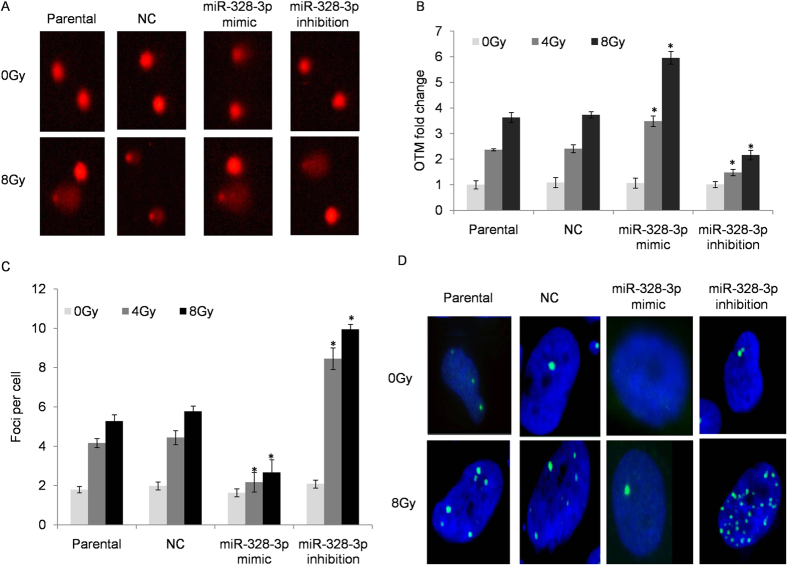
miR-328-3p over-expression increased radio sensitivity and promoted DNA damage of A549 cells.(A,B) Comet assay was performed to evaluate DNA damage response following miR-328-3p transfection. ANOVA test was used to determine the statistical significance of differences among the groups. Results presented as mean ± SEM of values obtained in three independent experiments. (C,D) Blue represents stained nuclei and green represents stained γ-H2AX foci. Mean number of foci per cell for various doses shown after 0 to 8 Gy of irradiation. *p < 0.05, compared to the parental control.